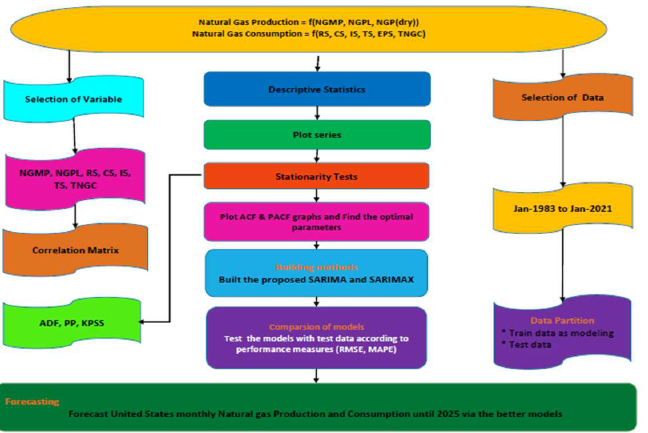
Figure 1. Research flowchart.